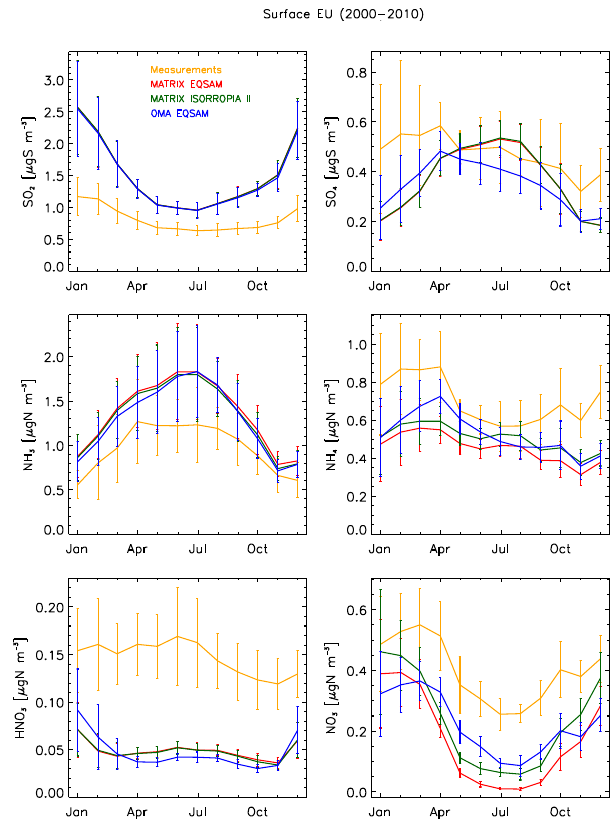
Figure 5. The 2000–2010 mean annual cycle over Europe, error bars represent ± 1 standard deviation. Measurements are in orange, MATRIX-EQSAM is in red, MATRIX-ISORROPIA II is in green, and OMA-EQSAM is in